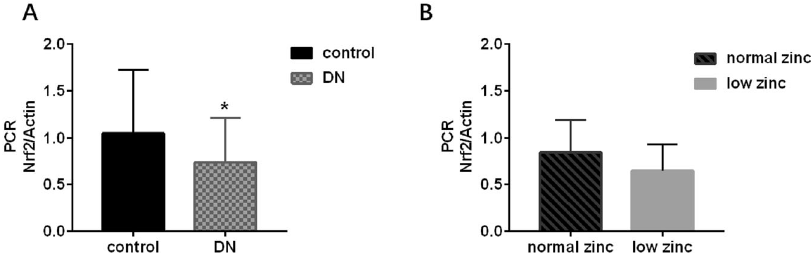
Fig. 2 Effect of zinc on Nrf2 expression in the blood of patients with DN. A RT-qPCR was performed to evaluate mRNA expression of Nrf2 in the blood of patients with DN and healthy people. B The mRNA expression of Nrf2 in the blood of patients with DN in the normal-zinc and low-zinc groups. Data are presented as means ± SD, * P < 0.05 versus the control group.